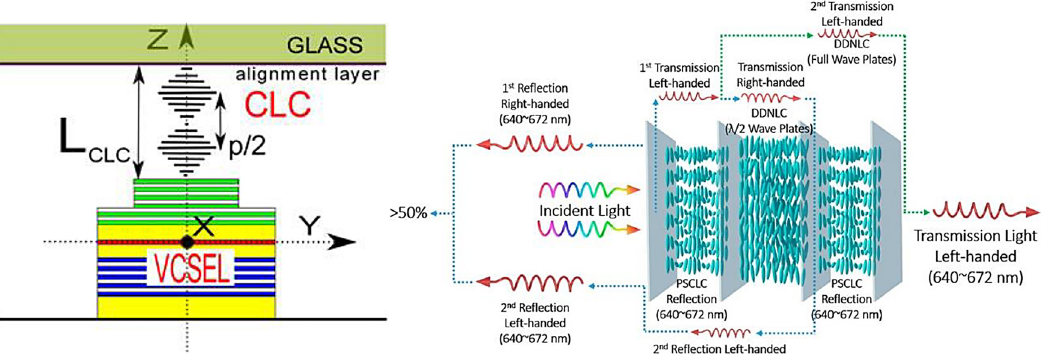
Figure 11: (left) Schematic of VCSEL with CLC overlay: the LC cell is closed from the top by a glass plate with a deposited LC alignment layer [83]. (right) Schematic of the LC-polymer composite laser with a symmetric sandwich structure in which a dye-doped nematic liquid crystal (DDNLC) layer is sandwiched between two polymer-stabilized cholesteric liquid-crystal (PSCLC)